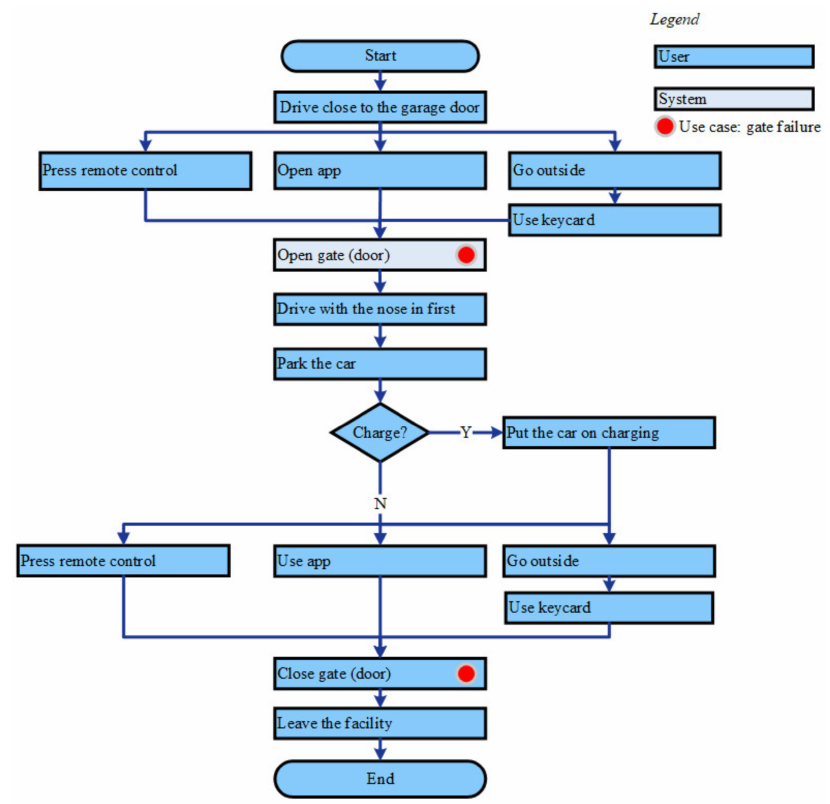
Figure 23. Workflow for car entry to the SOI.